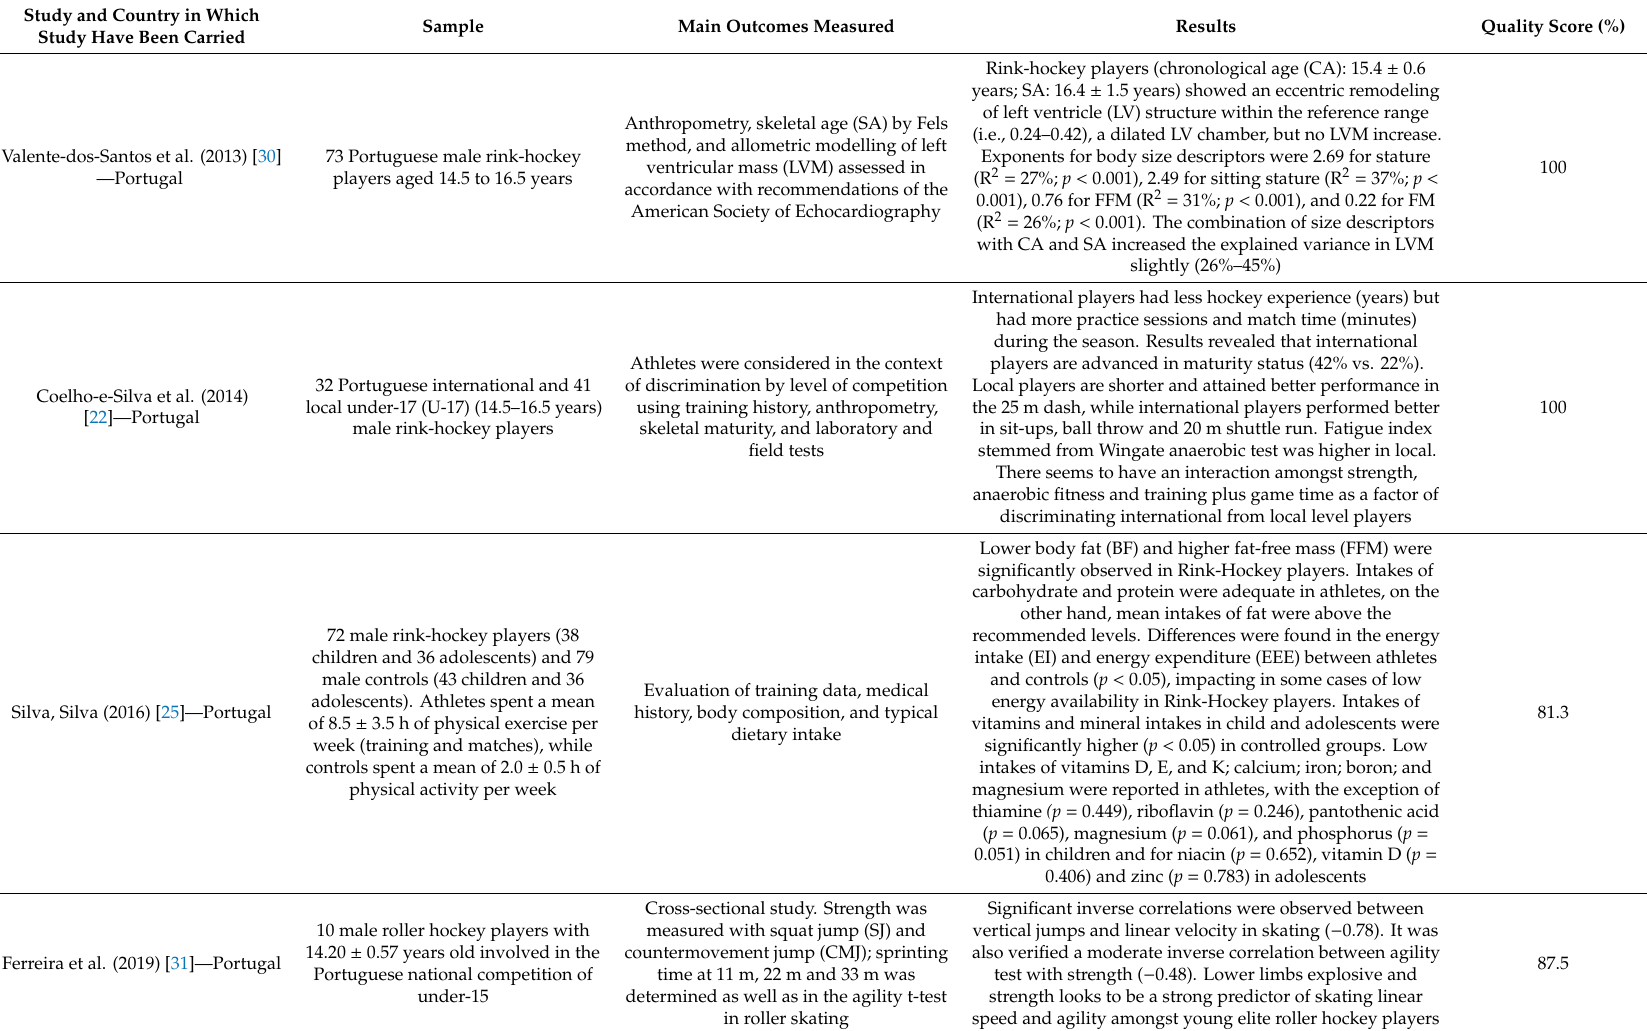
Table 2. Articles mainly related to anthropometric, body composition, and conditional